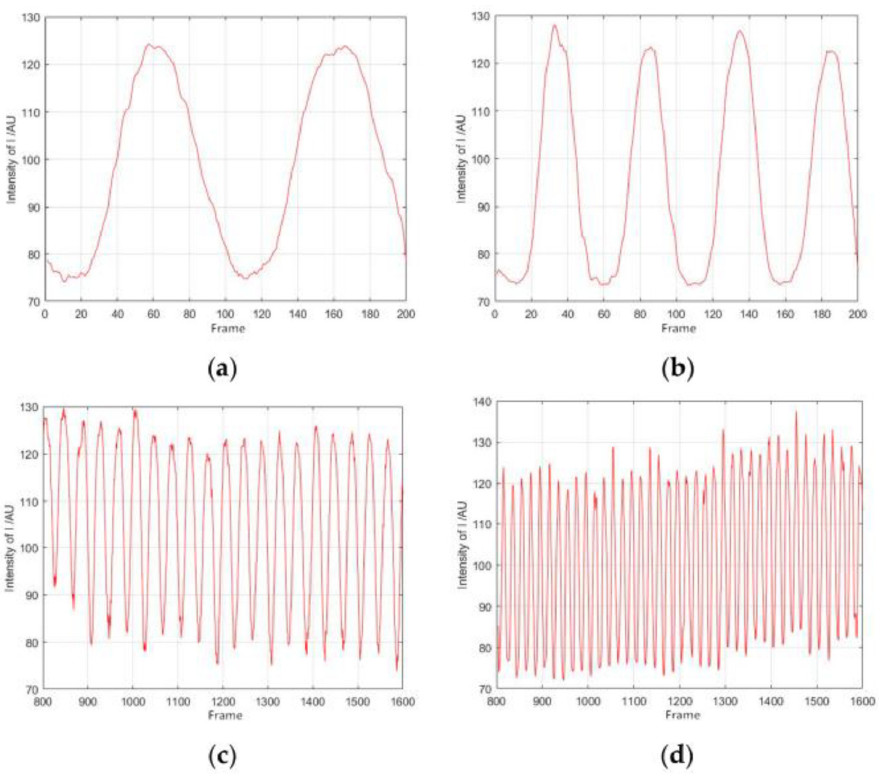
Figure 8. The light intensity curves at different frequencies when the amplitude is 40 nm. ( a ) f = 0.5 Hz; ( b ) f = 1 Hz; ( c ) f = 10 Hz; ( d ) f = 20 Hz. Then, we measure the vibrations with the same vibration frequency (10 Hz selected in the article) and different amplitudes, as shown in Figure 9. For the same reason men- tioned above, we choose the light intensity curves of 800 frames in 2 s.